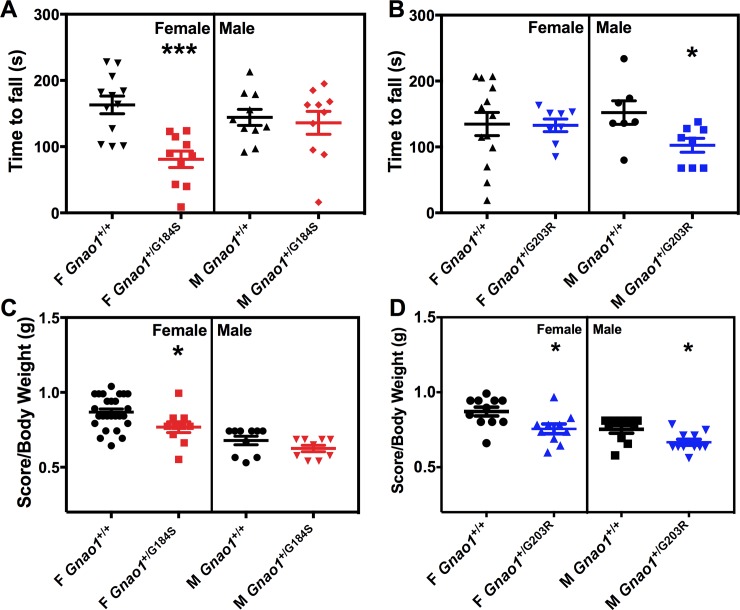
Female Gnao1+/G184S mice and male Gnao1+/G203R mice show reduced time on RotaRod and reduced grip strength.(A&B) Quantification of RotaRod studies. (A) Female Gnao1+/G184S mice lose the ability to stay on a RotaRod (unpaired t-test; ***p<0.001), while male Gnao1+/G184S mice appeared unaffected. (B) Male Gnao1+/G203R also showed reduced motor coordination on RotaRod (unpaired t-test, *p<0.01). (C&D) Quantification of grip strength results. Scores for each mouse were normalized to body weight. (C) Female Gnao1+/G184S mice are less capable of lifting weights compared to their Gnao1+/+ siblings (unpaired t-test, *p<0.05). (D) Both male and female Gnao1+/G203R mice showed reduced ability to hold weights (unpaired t-test, *p<0.05). Data are shown as mean ± SEM.